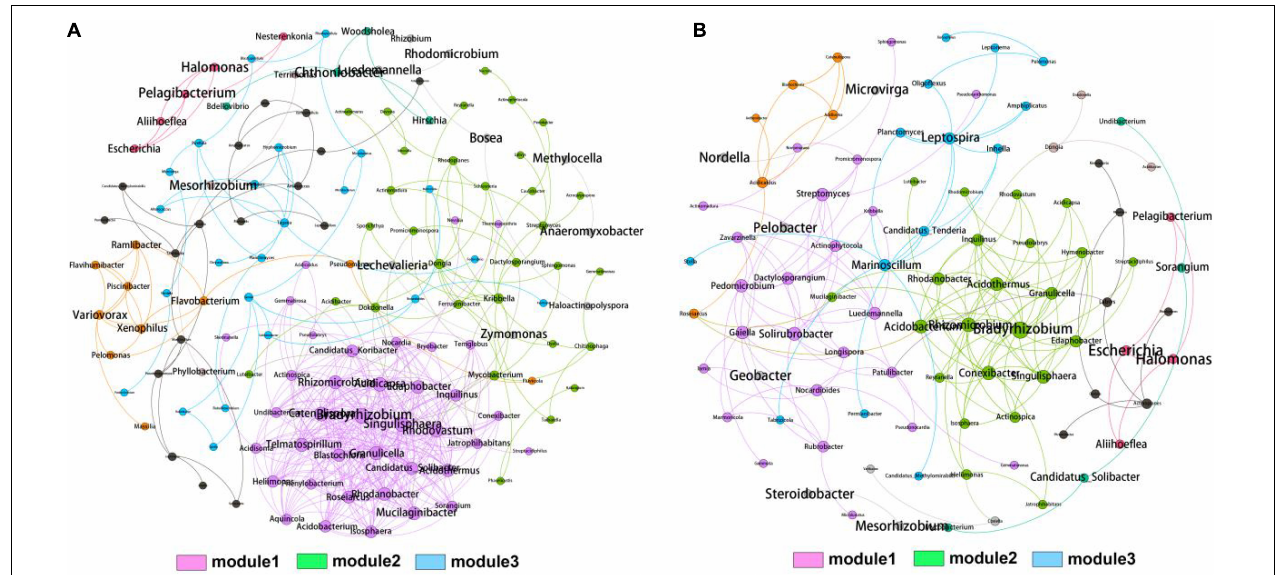
FIGURE 4 | Co-occurrence network analysis of bacterial community from rhizosphere (A) and bulk soil (B) samples. A connection represents a strong (spearman’s r cutoff > 0.75) and significant ( p cutoff < 0.01) correlation. The size of each node is proportional to the degree of connections. Three MCODE modules with close interaction were identified based on the